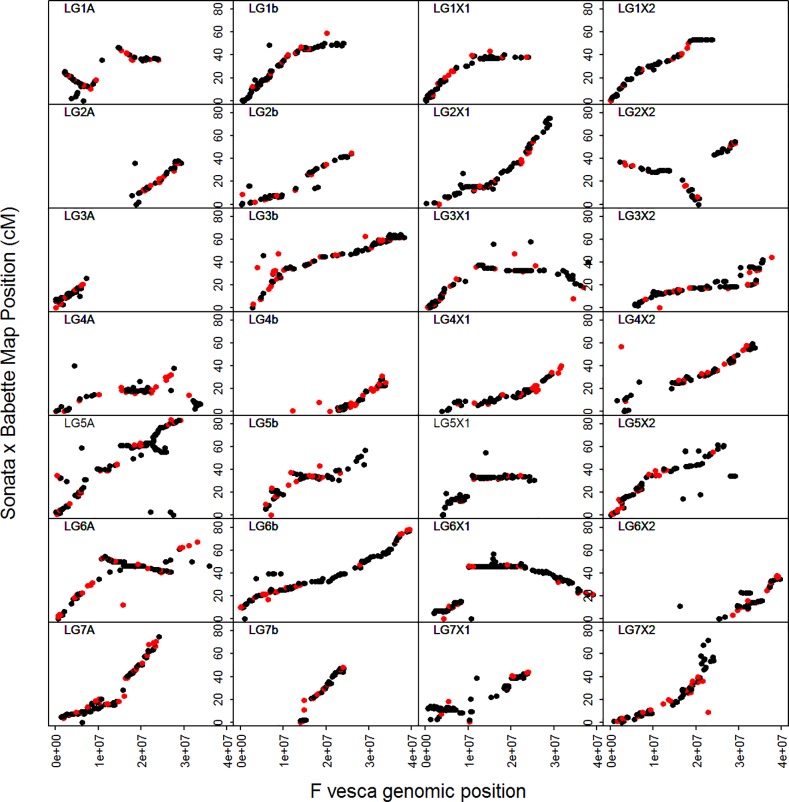
Marey maps depicting the relationships and colinearity between the markers’ physical position on the F.vesca v4.0 genome sequence and the genetic positions on the ‘Sonata’ and ‘Babette’ linkage groups. Genetic distances are plotted on the y-axes and physical distances on the x-axes. Red points indicate the positions of ddRAD markers, whilst black points indicate the positions of Axiom iStraw90 markers.